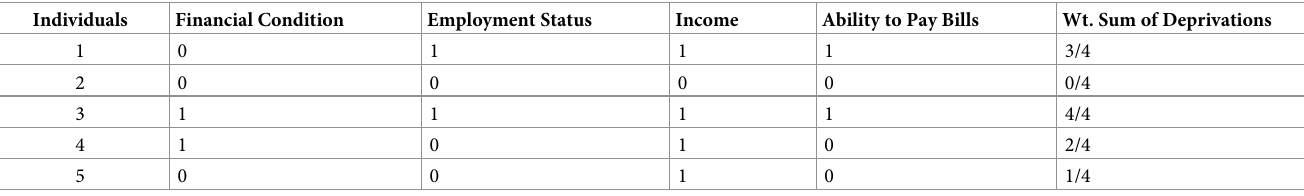
Table 2. Illustrative example of multidimensional deprivation measures.